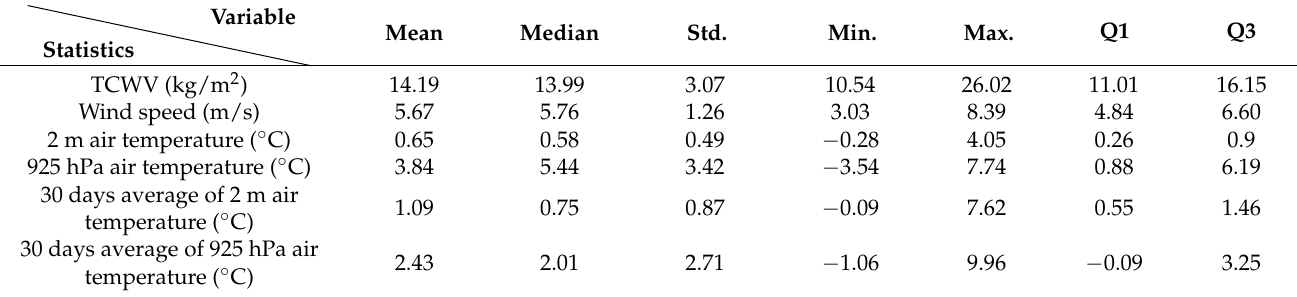
Figure 8. Comparisons of SIC values computed from Landsat-8 ice/water maps with those from the ( a ) RF model and ( b ) BT and ( c ) ASI algorithms. Table 3. Descriptive statistics of atmospheric conditions used in the RF SIC retrieval corresponding to the Landsat-8 SIC ( T B : brightness temperature, H : horizontally polarized channel, V : vertically polarized channel, Q1: 25th percentile, Q3: 75th